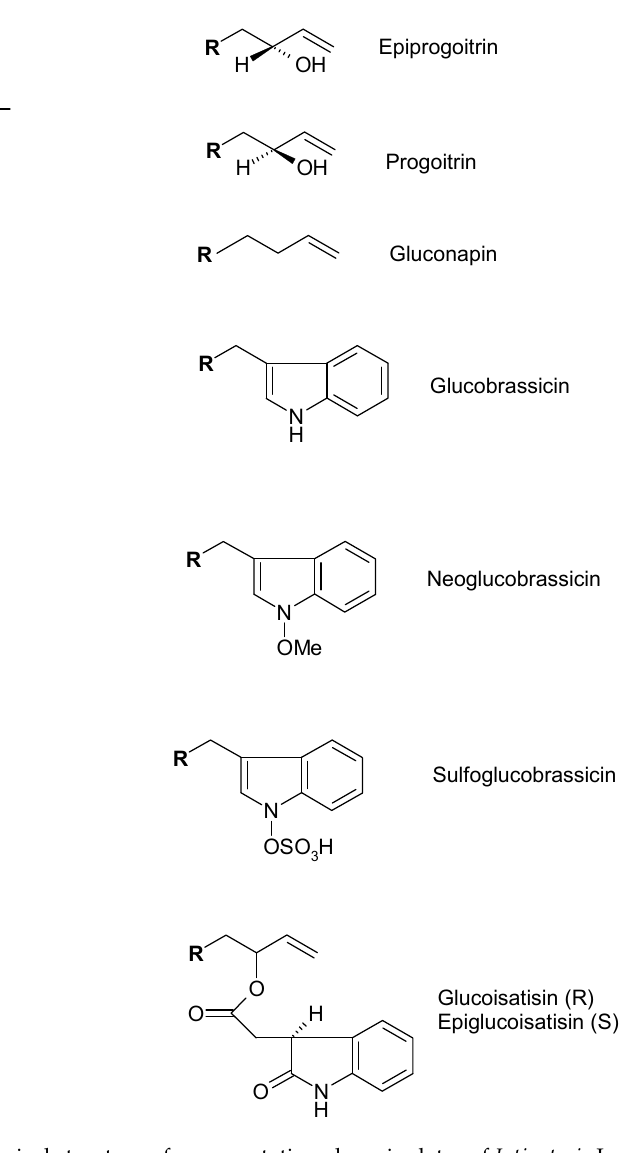
Figure 7. Chemical structure of representative glucosinolates of I. tinctoria L.